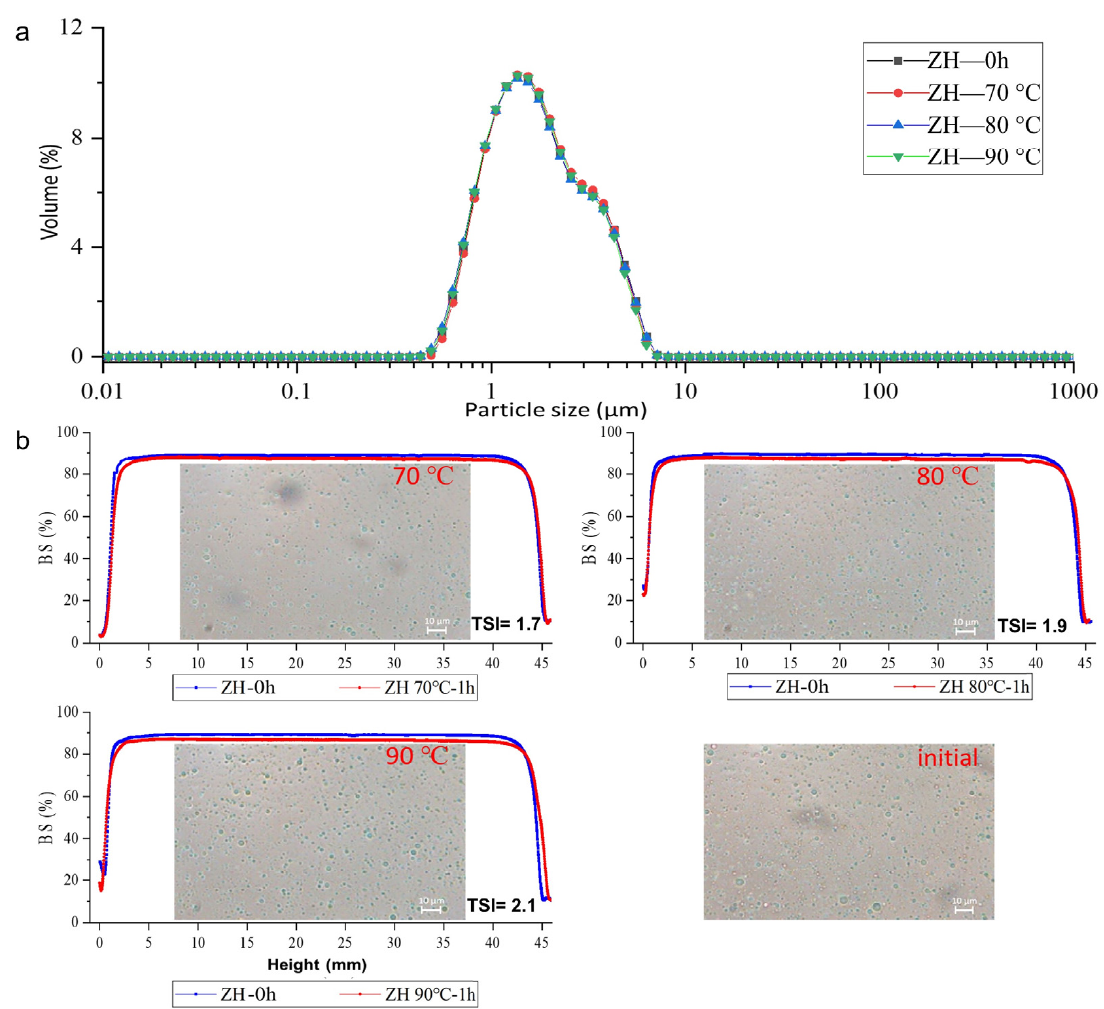
Figure 4. Particle size distribution of emulsions stabilized by ZH 0.6–70 after thermal treatment ( a ); Back-scattered light map and microscopic images (scale bar =10 µm) of emulsions stabilized by ZH 0.6–70 before and after heating under different temperatures ( b ).